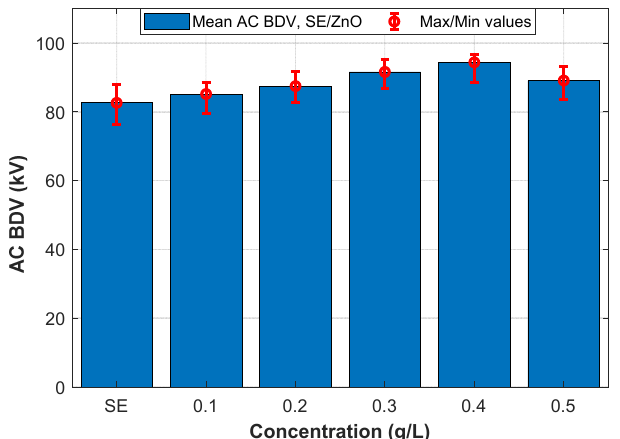
Figure 6. Comparison between the improvements of breakdown voltages of different nanofluids for different concentrations.